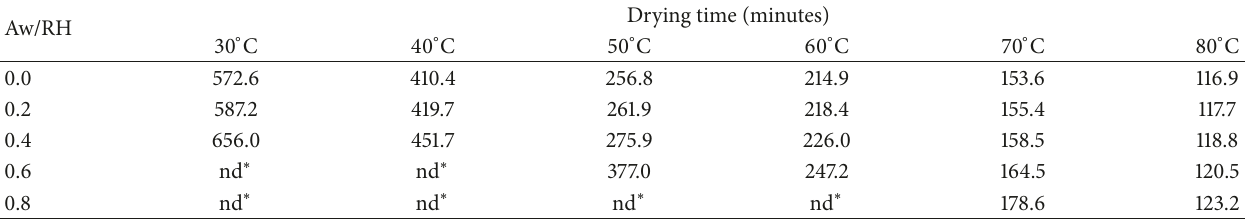
Table 1: Predicted drying time of roselle extract without foam at various air conditions.